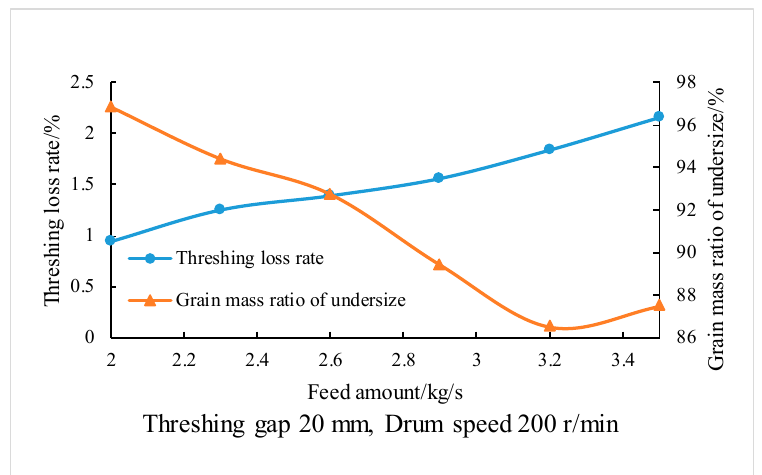
Figure 10. Effect of the feed amount on the threshing performance.